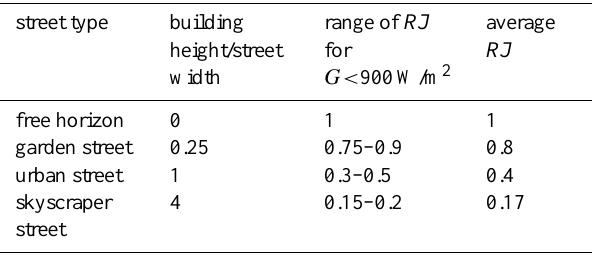
Table 1. Averaged reduction factors RJ for different street